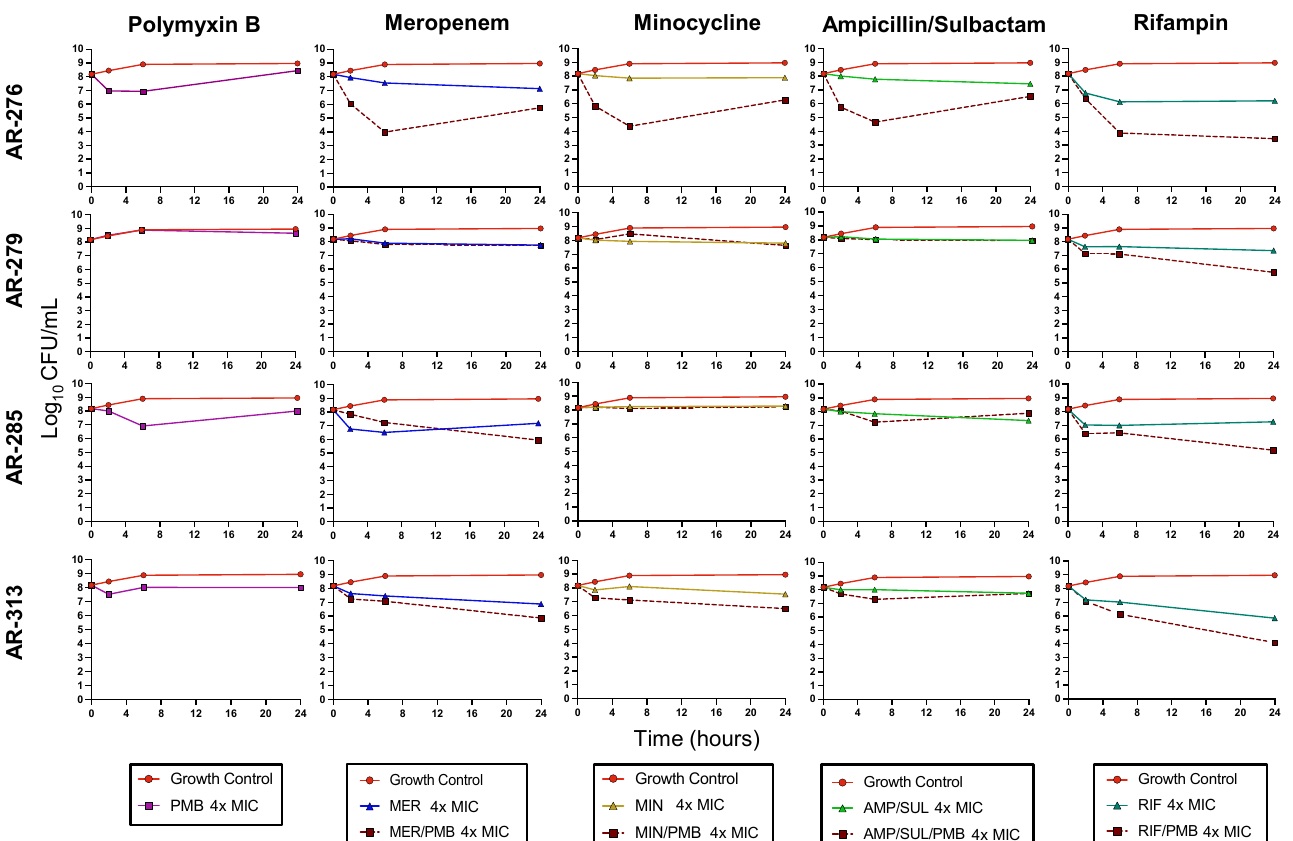
Figure 2. Mean viable bacterial counts of CRAB biofilms in static time ‐ kill experiment. For combinations, each antibiotic was tested at a concentration of 4 × MIC. PMB, polymyxin B; MER, meropenem; MIN, minocycline; AMP/SUL, ampicillin/sulbactam; RIF, rifampin. PMB and RIF was the most active combination against the biofilms. This combination was bactericidal against AR ‐ 276 and AR ‐ 313 and caused a 2.99 log 10 CFU/mL reduction against AR ‐ 285. The combination of PMB and RIF was also synergistic against AR ‐ 276 and AR ‐ 285. The mean bacterial reduction against all four isolates caused by PMB combined with RIF was 3.55 log 10 CFU/mL at 24 h. PMB/MER was not bactericidal or synergistic